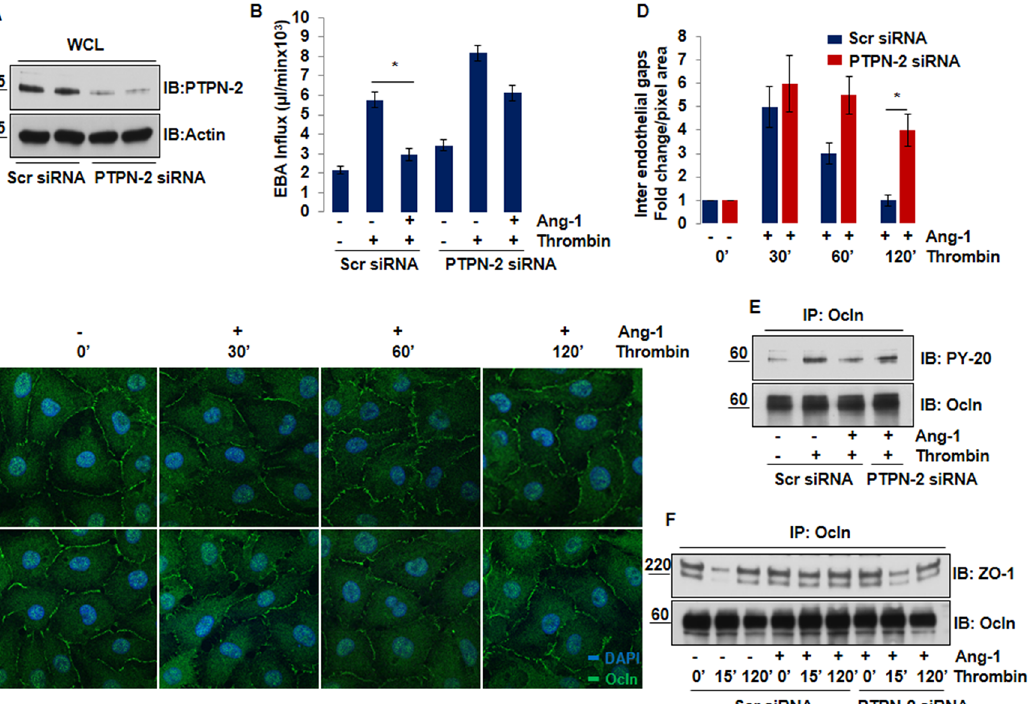
Fig 4. Deletion of PTPN-2 abolishes barrier protective function of Ang-1. (A) HBMECs were transfected with 50nM of either scramble or PTPN-2 siRNA. After 48 hours of transfection, cell lysate was collected, and immunoblotted with anti-PTPN-2 antibody to see the knockdown efficiency. The same blot was reprobed for Actin. ( B) EBA permeability was determined in HBMECs monolayers transfected by 50nM scramble siRNA or PTPN-2 siRNA. Cells were treated with 100nM of thrombin for 120 min alone and after Ang-1 (100ng/ml for 15 min). Bar graphs show the average ± SEM, * P < 0.05. ( C) Representative confocal images of Occludin staining to show cell-cell contact in confluent HBMECs transfected with either scramble siRNA or PTPN-2 siRNA. ECs were then pretreated with Ang-1 (100ng/ml for 15 min) followed by thrombin treatment. Scale bar = 10 μ M. ( D) Quantification of number of inter-endothelial gaps is shown in fold change. Data are represented as mean ± SEM * P < 0.05. ( E) HBMECs were transfected with 50nM scramble siRNA or PTPN-2 siRNA for 48 hr. Serum starved ECs monolayer was stimulated by thrombin (100nM for 15 min) alone and after Ang-1 pretreatment (100ng/ml for 15 min). Level of pY-Occludin and total Occludin was determined by immunoprecipitation and Western blot analysis. ( F) ECs were transfected with 50nM of scramble or PTPN-2 siRNA for 48 hr followed by exposure to 100nM of thrombin in absence or presence of Ang-1 pretreatment (100ng/ml for 15 min). Immunoprecipitation was used to study Occludin/ZO-1